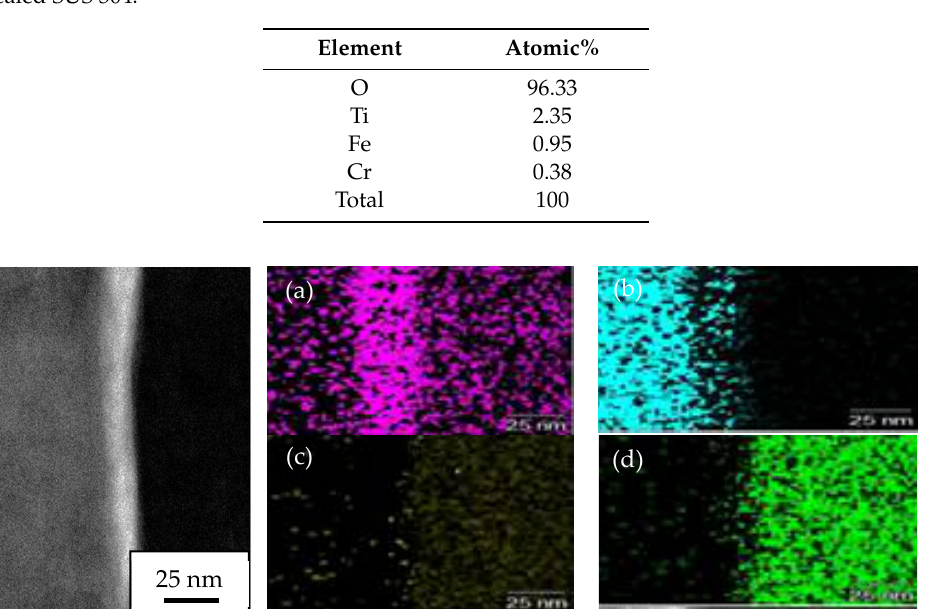
Table 3. Chemical composition analysis by EDS for the interface at the rebound region, R of TiO 2 / 1000 ◦ C annealed SUS 304.